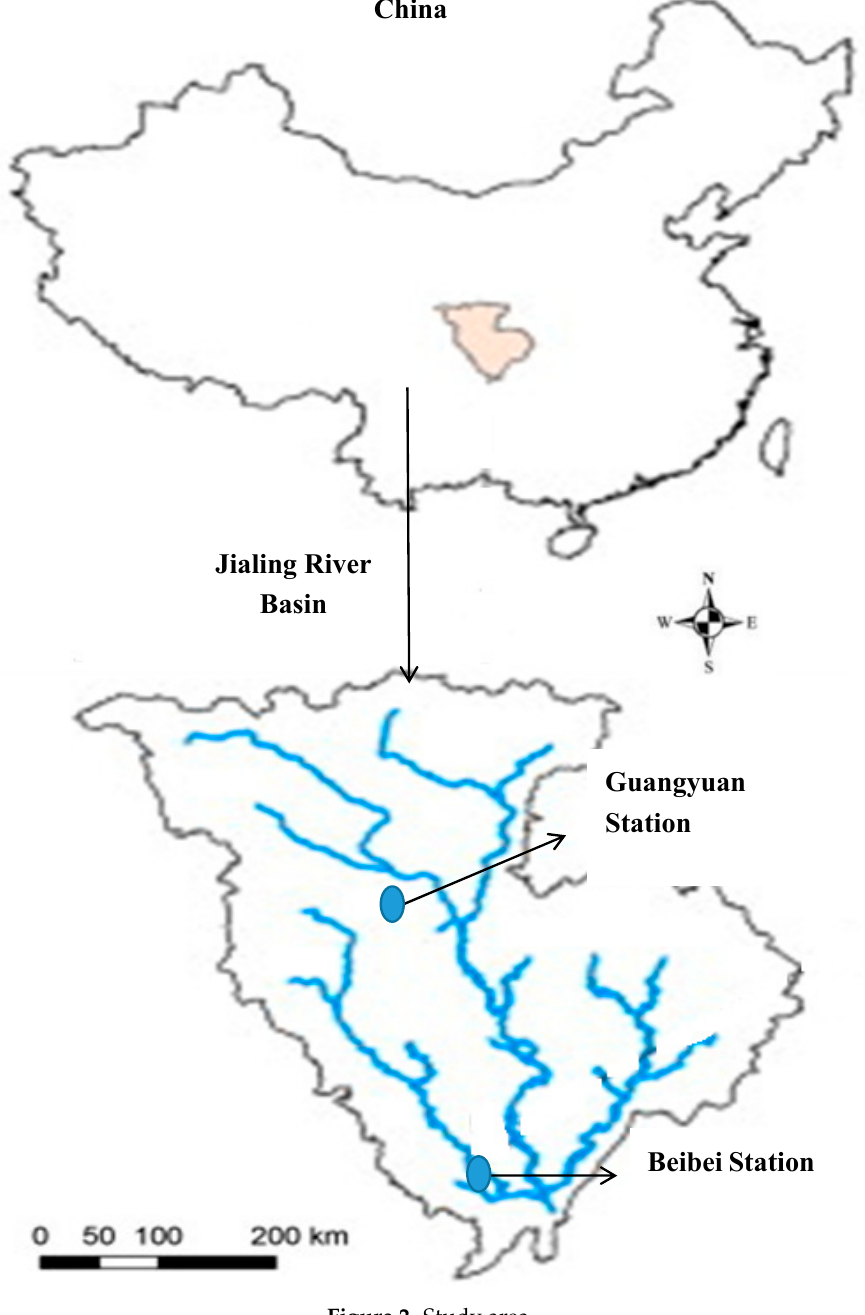
Figure 2. Study Figure 2. Study area.